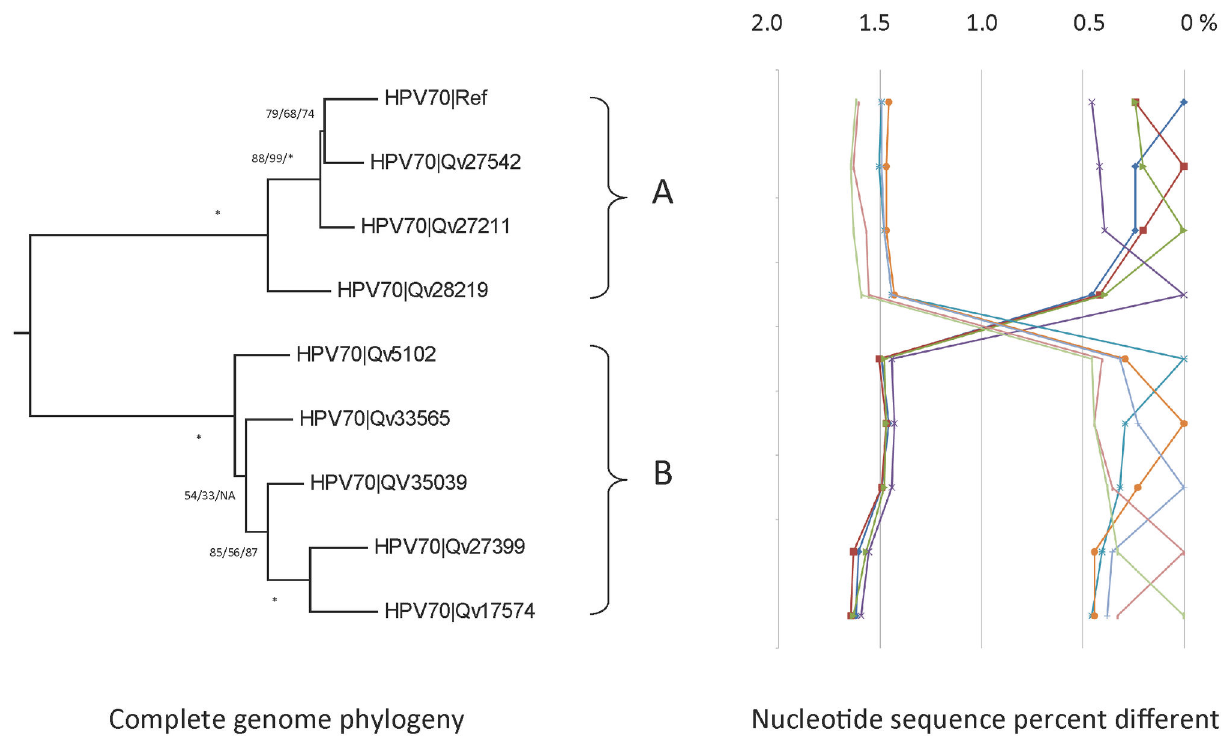
Figure 7. HPV70 variant tree topology and pairwise comparisons of individual complete genomes. The phylogenetic tree was constructed as described in Figure 2. Distinct variant lineages and sublineages were determined as described in Figure 2. The percent nucleotide sequence differences are shown in the panel to the right of the phylogenetic tree as described in Figure 2. doi: